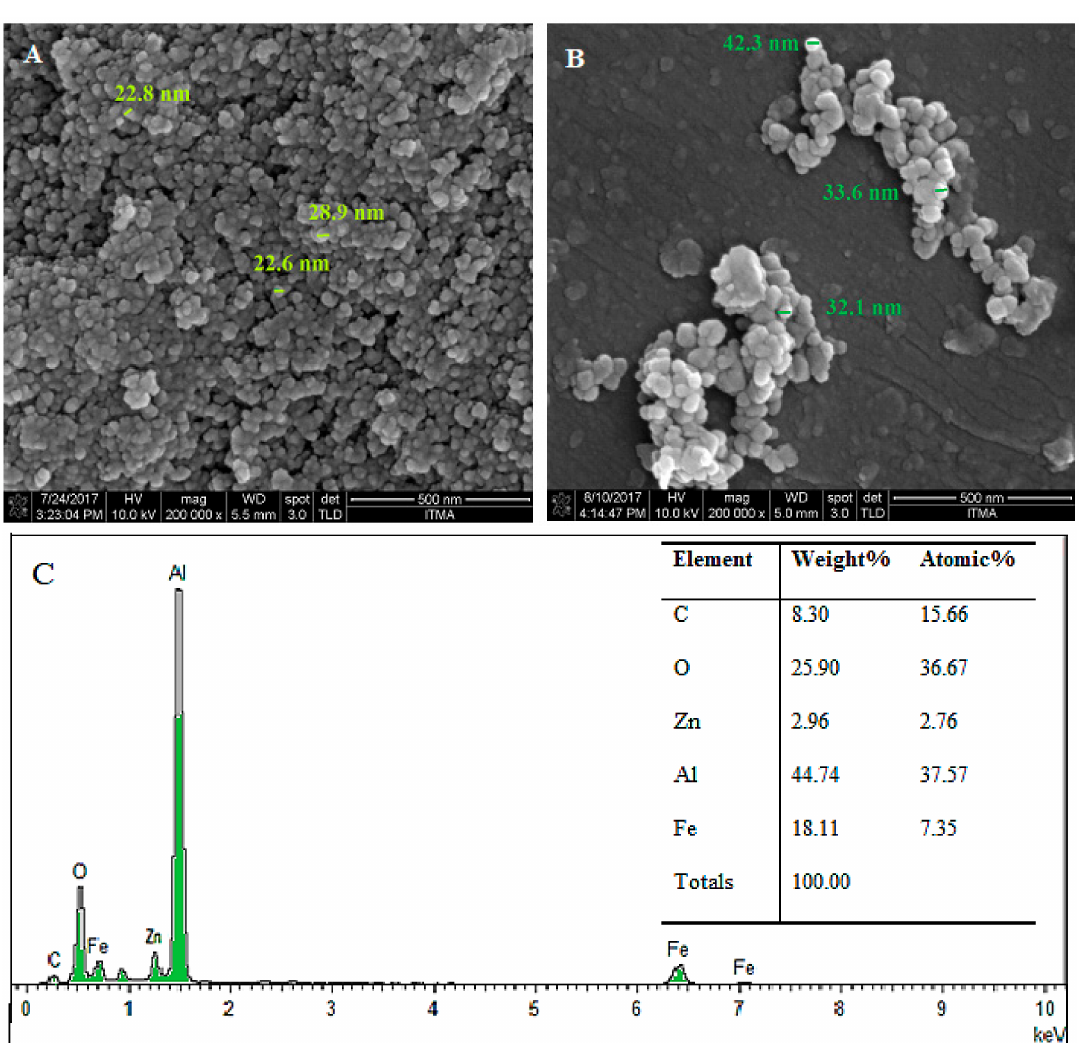
Figure 5. FESEM images of the samples: The pure Fe 3 O 4 nanoparticles ( A ); FPVAFU-ZLDH ( B ); and EDS data of the prepared samples ( C ). The sample holder is manufactured of aluminum, so the resulting spectrum exhibits a high percentage of aluminum, and it is unreliable to represent the amount of aluminum in the